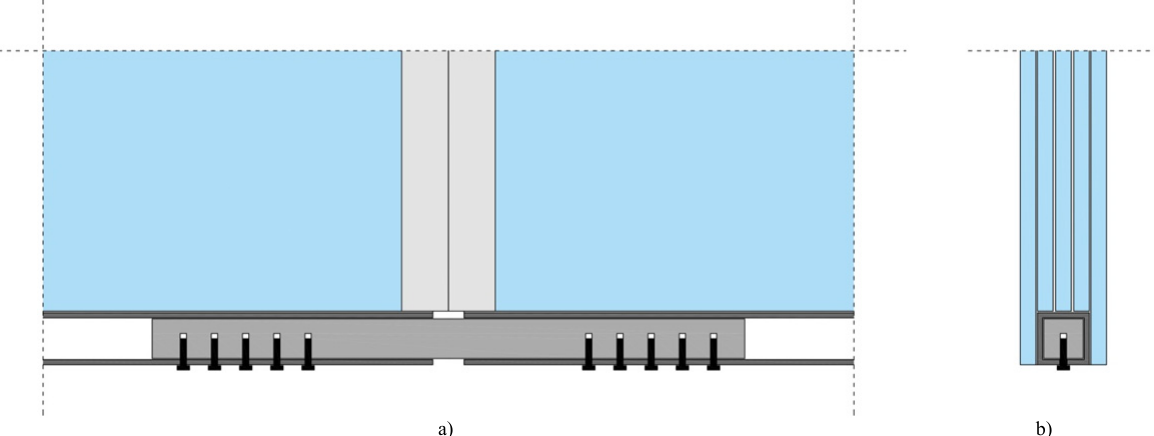
Fig. 4 Concept of the transfer of tensile